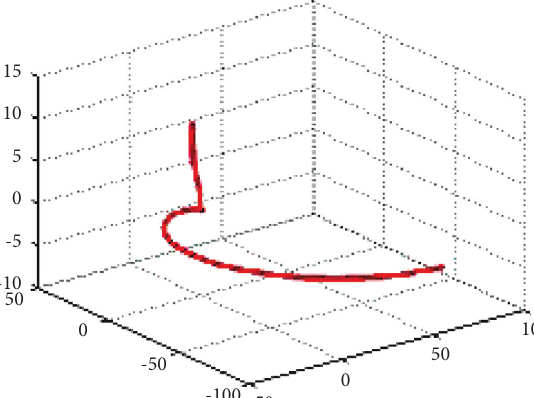
Figure 6: 2 D 2 α r -direction curve of